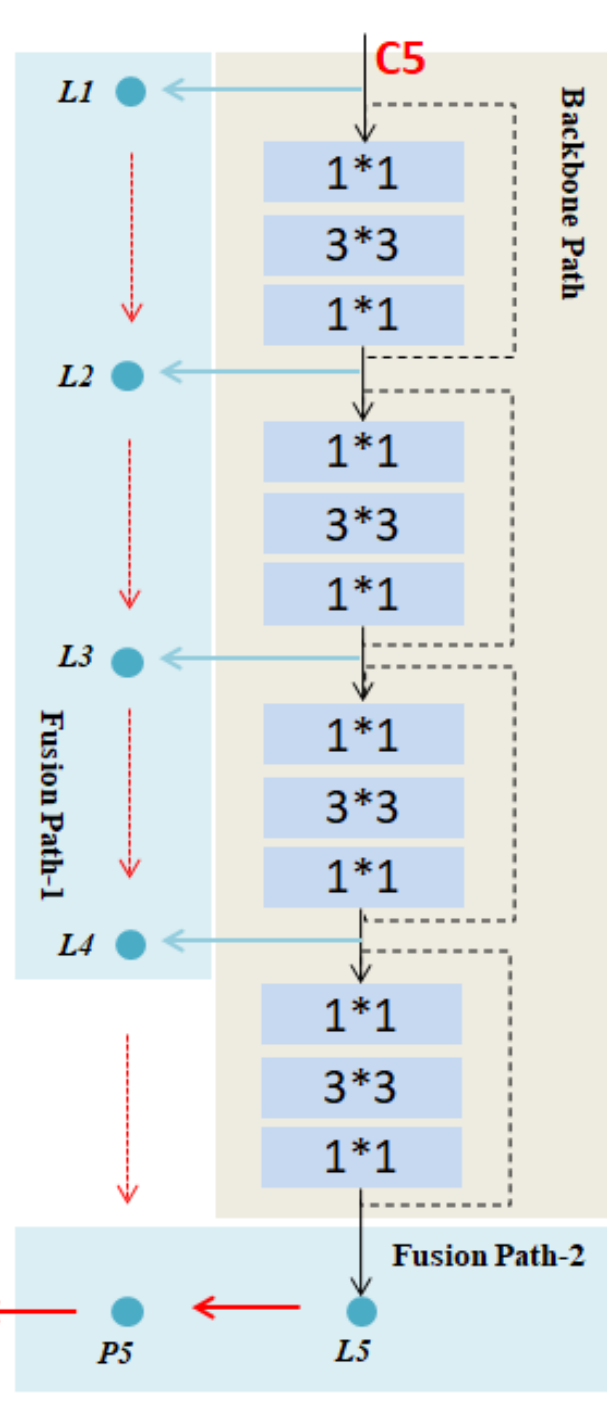
Figure 3. SFMF Architecture.